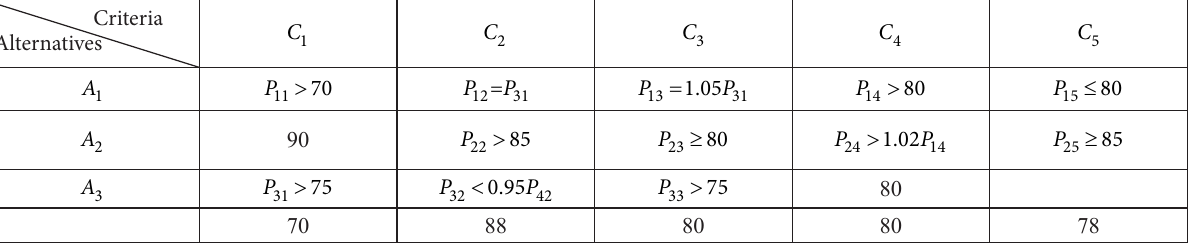
Table 2. Evaluation information about criteria given by the decision makers Criteria Alternatives